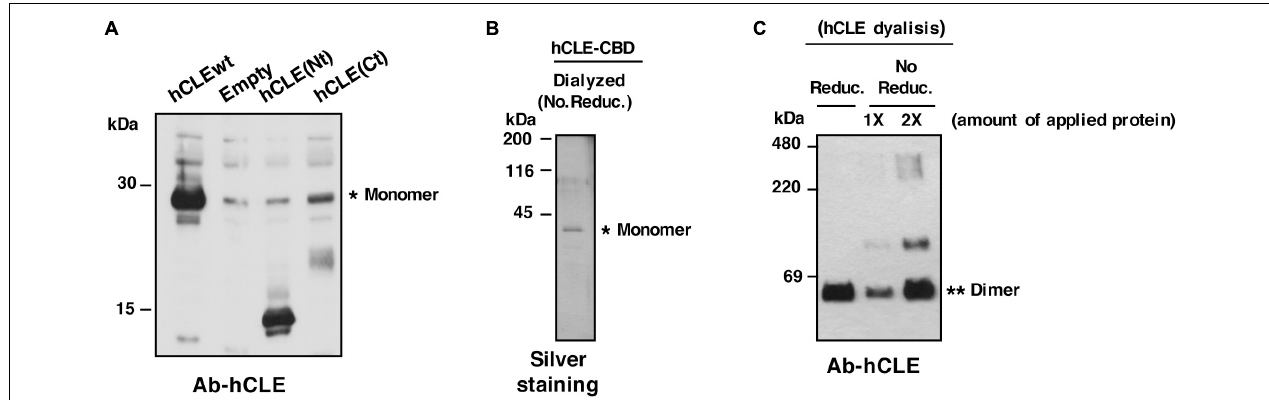
FIGURE 2 | hCLE forms oligomers. (A) Total protein extracts of HEK293T cells transfected with plasmids expressing the whole hCLE sequence (hCLEwt), N-terminal domain [hCLE(Nt)] (aa 1–120) or C-terminal domain [hCLE(Ct)] (aa 120–244) were analyzed by Western blot with anti-hCLE antibodies. (B) Silver staining of hCLE-CBD purified protein dyalized in the presence of non-reducing agents (No. Reduc.). (C) Purified hCLE was dyalized in reducing (Reduc.) or non-reducing buffer (No Reduc.) and analyzed in non-denaturing gel followed by Western blot with anti-hCLE antibodies. ∗ monomer and ∗∗ dimers. 1X and 2X represent single or double amount of purified protein. Three independent experiments were